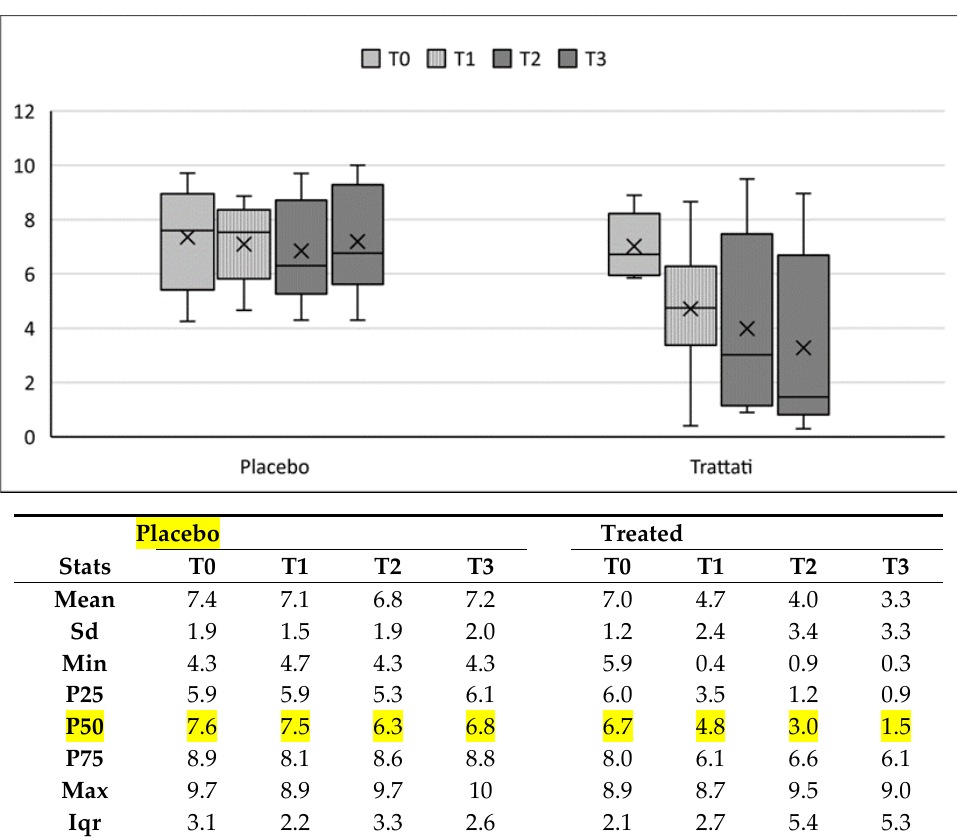
Figure 4. VAS scale Box, Placebo group and treated, from T0 to T3. The boxplot shows the analysis of the below reported statistical data; the main value is represented by the P50 due to the asymmetric distribution of pain levels among patients in each group. It is easily seen that there are no significant differences in the Placebo Group while a significant decrease appears in the Treated Group, from 6.7 at T0 to 4.8 at T1, 3.0 at T2 and 1.5 at T3.